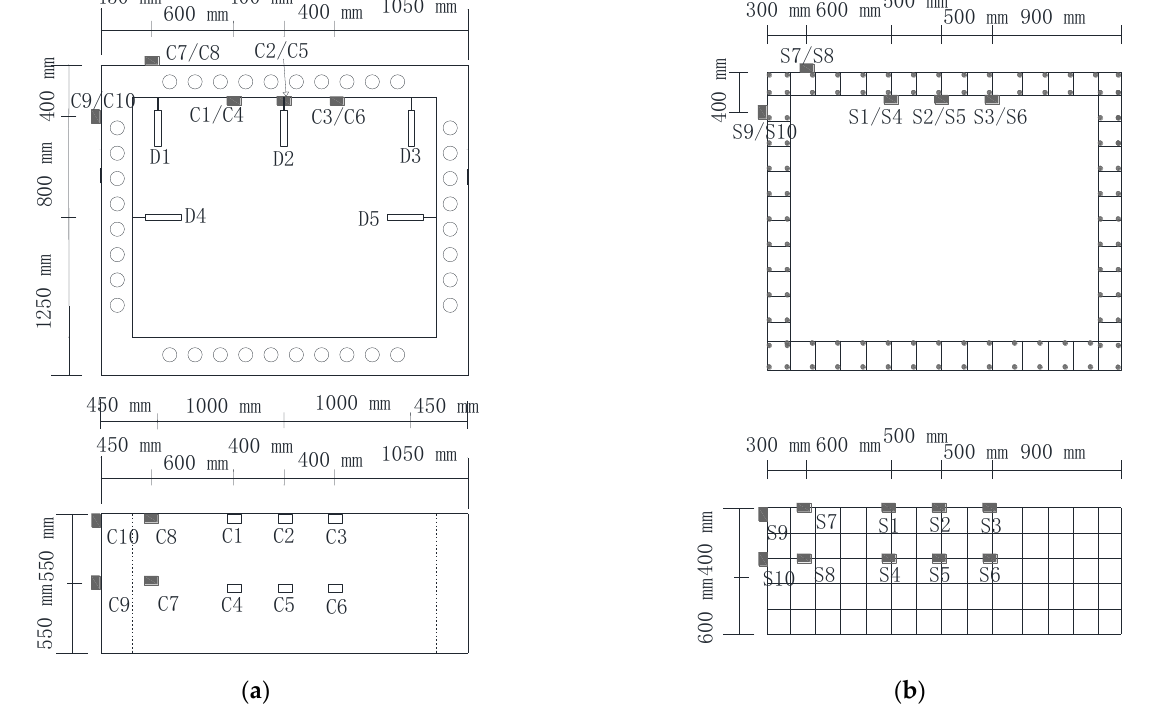
Figure 3. Support and loading position. ( a ) Concrete strain gauges and displacement transducer placement. ( b ) Reinforced strain gauges placement.